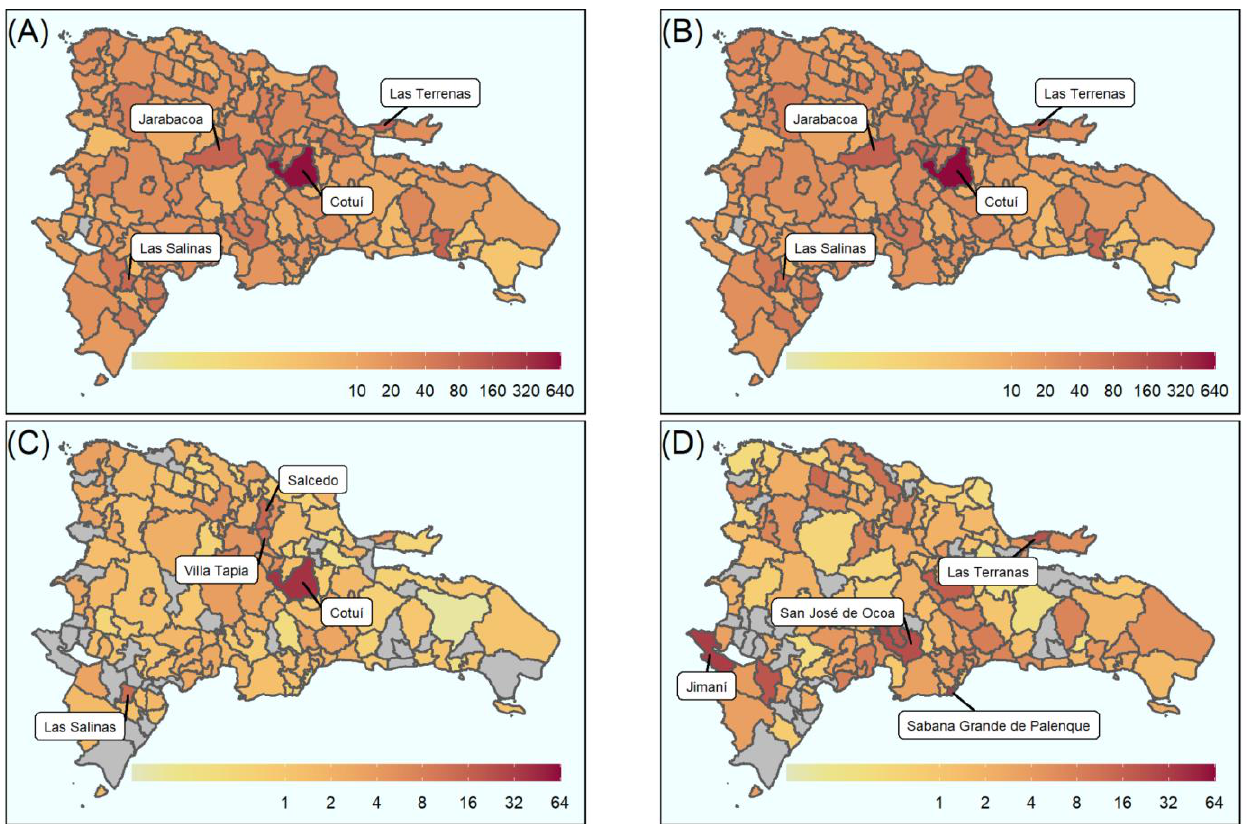
Figure 2. Aggregated spatial distribution of cases over the 2014–2016 epidemic period at the municipal level: ( A ) uncomplicated dengue; ( B ) dengue; ( C ) complicated dengue; ( D ) Zika. Continuous colour scale from white (lowest) through to red (highest) for all images; scales vary. Grey areas indicate no data for those municipalities. All counts per 10,000 population.